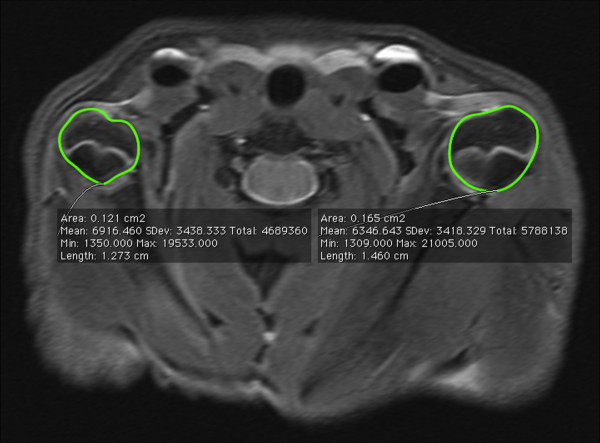
Shoulder MRI 8 weeks after surgery showing a decrease of humeral head sectional area that reproduces the joint hypoplasia found in children.